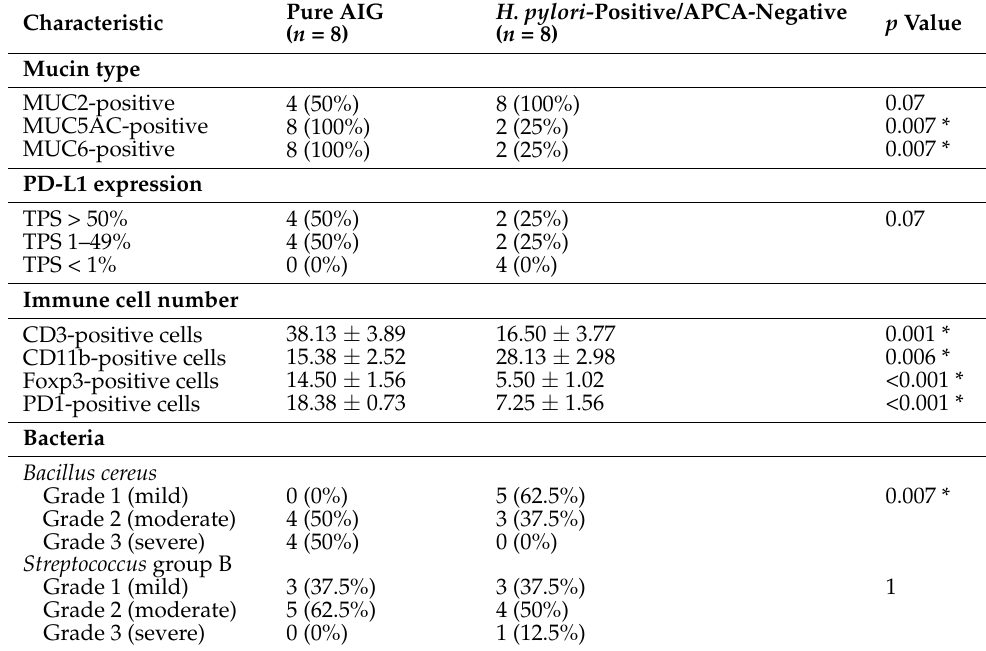
Table 4. Mucin type, immune cell numbers, PD-L1 expression, and